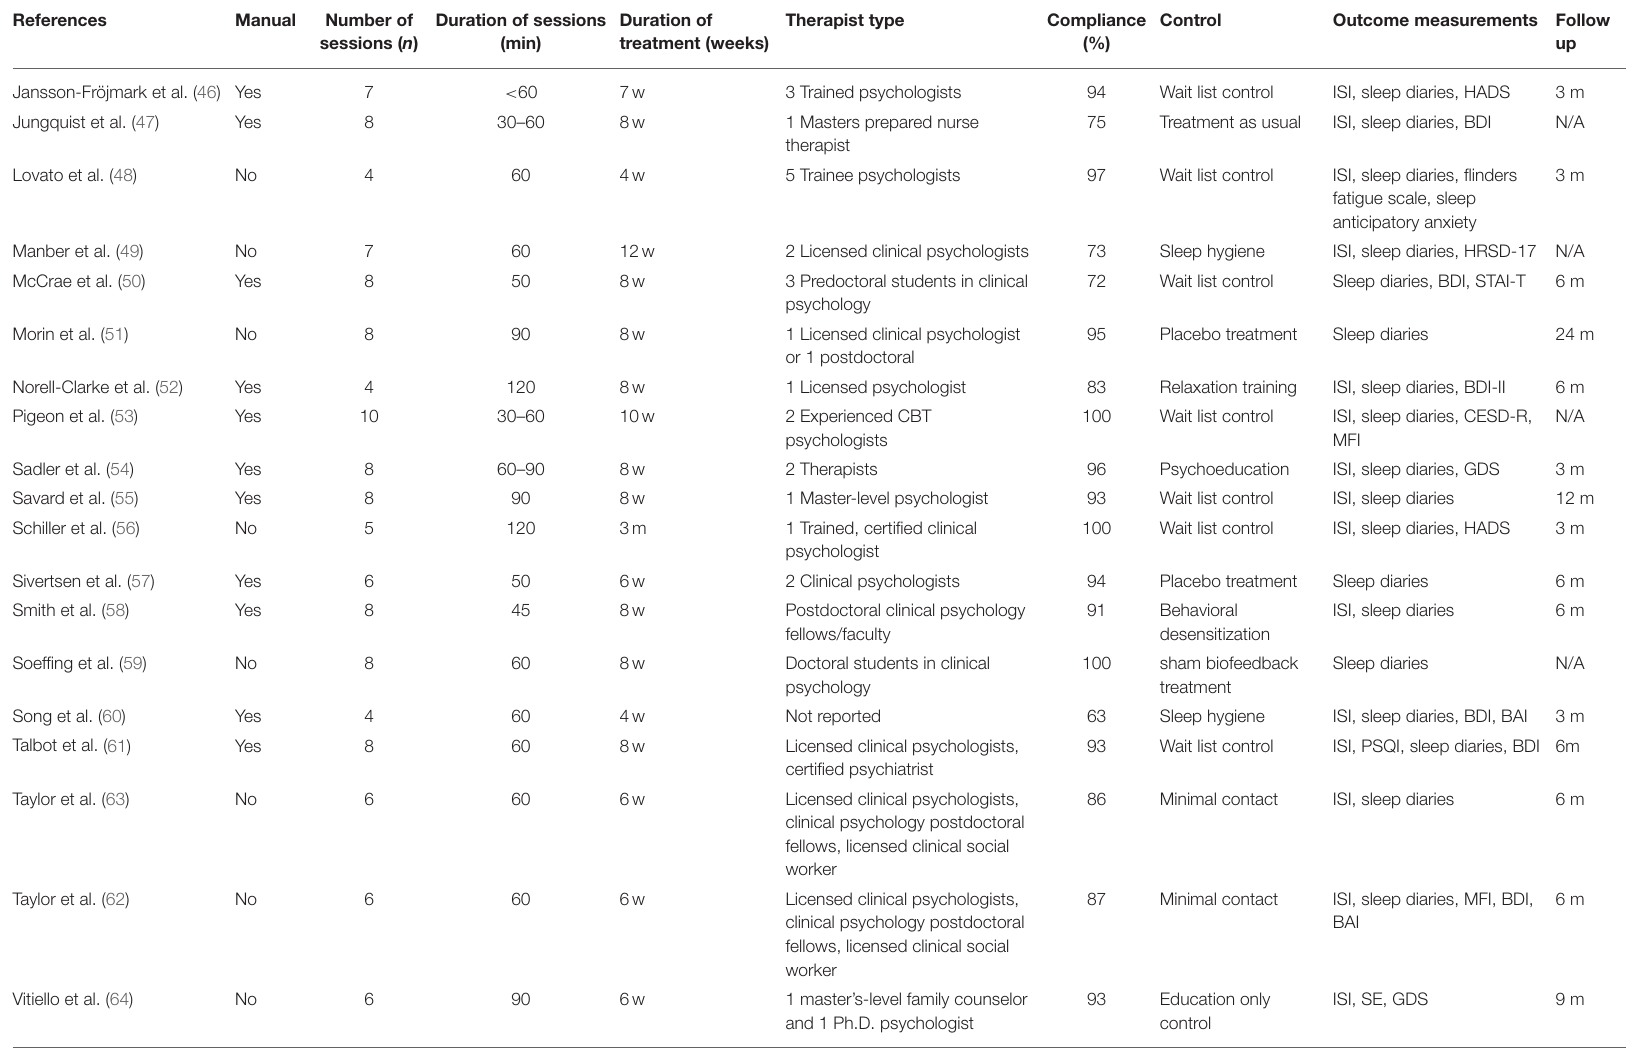
BAI, Beck anxiety inventory; BDI, Beck depression inventory; CBT, cognitive behavioral therapy; CESD-R: Center for Epidemiologic Studies Depression Scale-revised; DSISD, Duke structured clinical interview for insomnia; DSM-IV, diagnostic and statistical manual of mental disorders fourth edition; DSM-5, diagnostic and statistical manual of mental disorders fifth edition; FSS, fatigue severity scale; GDS, geriatric depression scale; HADS, hospital anxiety and depression scale; HAMD-17, Hamilton depression rating scale; HRSD-17, 17-item Hamilton rating scale for depression; ICSD, international classification of insomnia; IIS, insomnia interview schedule; ISI, insomnia severity index; MFI, multidimensional fatigue inventory; PSQI, Pittsburgh Sleep Quality Index; PTSD, posttraumatic stress disorder; PEDro, Physiotherapy Evidence Database; RT, relaxation training; SDS, self-rating depression scale; SCID, structured clinical interview for DSM-IV; SCL 90, symptom checklist 90; SE, sleep efficiency; SF-36: 36-item medical outcomes study short-form general health survey; SOL, sleep onset latency; STAI-T, state-trait anxiety inventory-trait subscale; TWT, total wake time; WASO, wake after sleep